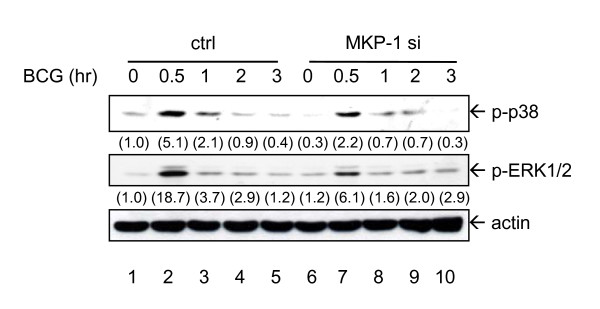
BCG-induced MAPK phosphorylation is decreased by MKP-1 siRNA. Transfection was done as in Figure 4, and BCG (MOI = 1 CFU/cell) was added for the indicated time points. Protein samples were harvested and levels of phospho-p38 MAPK (p-p38), phospho-ERK1/2 (p-ERK1/2) and actin were measured by Western blotting. Independent experiments were done on monocytes from 4 different donors and one representative set of results is shown. The intensities of the protein bands were determined by using Bio-Rad Quantity One imaging software. The intensities of phospho-proteins were normalized to the corresponding actin. The values in parenthesis are the relative normalized intensities compared to those of control siRNA-transfected cells without other treatment.